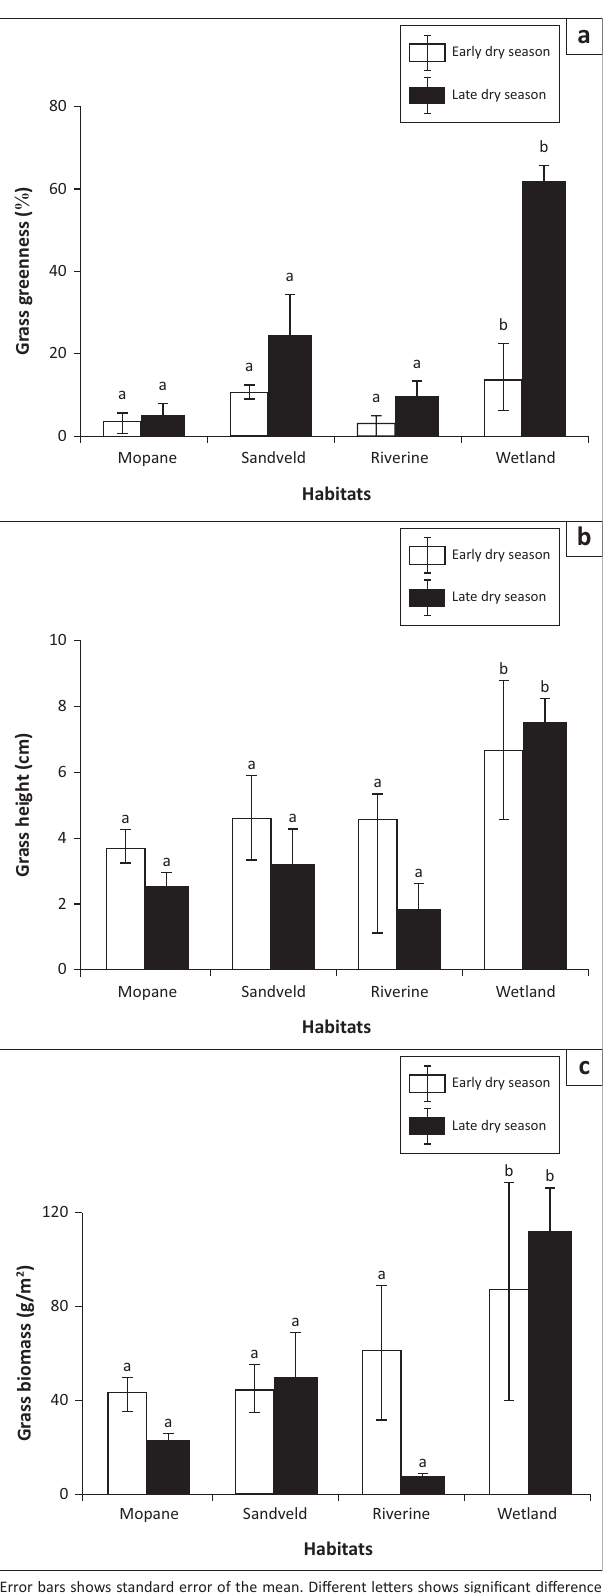
FIGURE 7: (a) Grass greenness, (b) height and (c) biomass of mopane woodland, sandveld, riverine and wetland used by buffalo herds during the early and late dry